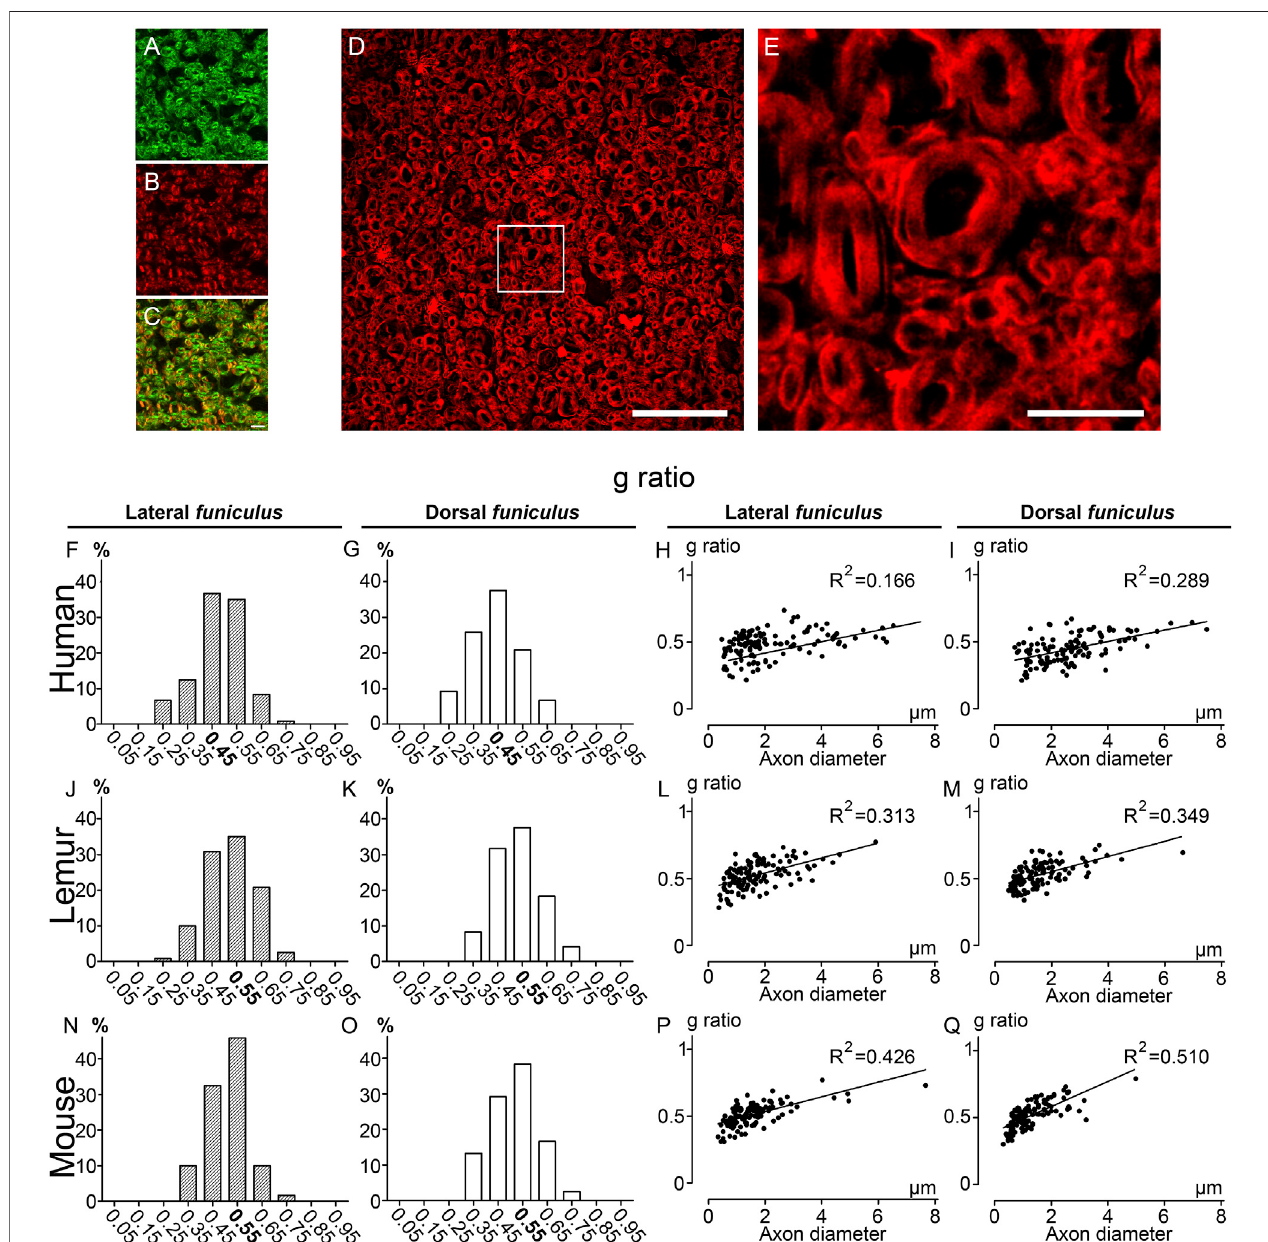
FIGURE4 | g-ratio distribution in humans, lemurs, and mice using fl uoromyelin staining CARSimage ofan axial section ofthe human thoracicspinal cord showing the lateral funiculus (A) stained with fl uoromyelin (B) . Merge of both signals (C) . Axial section of the human thoracic spinal cord showing the lateral funiculus stained with fl uoromyelinandimagedwithThunderImager (D) .Highermagni fi cationofthewhiteboxpresentedinD (E) .Distributionsofg-ratioinlateral (F , J , N) anddorsal (G , K , O) funiculi were quanti fi ed in humans (F , G) , lemurs (J – K), and mice (N-O) . Scatter plots of g-ratio against axon diameter in the lateral (H , L , P) and dorsal (I , M , Q) funiculi in humans (H-I) , lemurs (L – M), and mice (P – Q) . Correlation between g-ratio and axon diameter is expressed by the linear correlation coef fi cient ( R 2 ) of the linear regression curve. Each group included three individuals. The number of fi bers analyzed: 120 per group. Scale bars: (A-C, E) 10 μ m, (D) 50 µm.